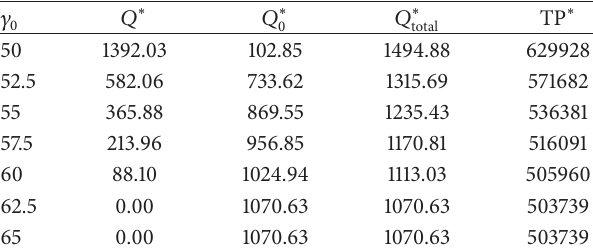
Table 3: Effect of changing 𝛾 0 on the optimal policy.